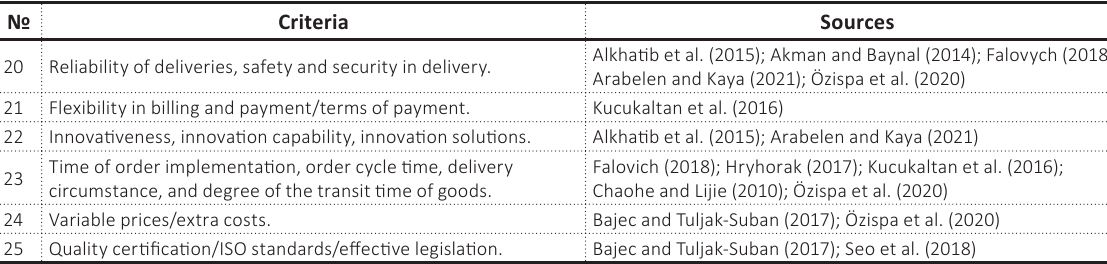
Table 1 (cont.). Criteria for evaluating the logistics service